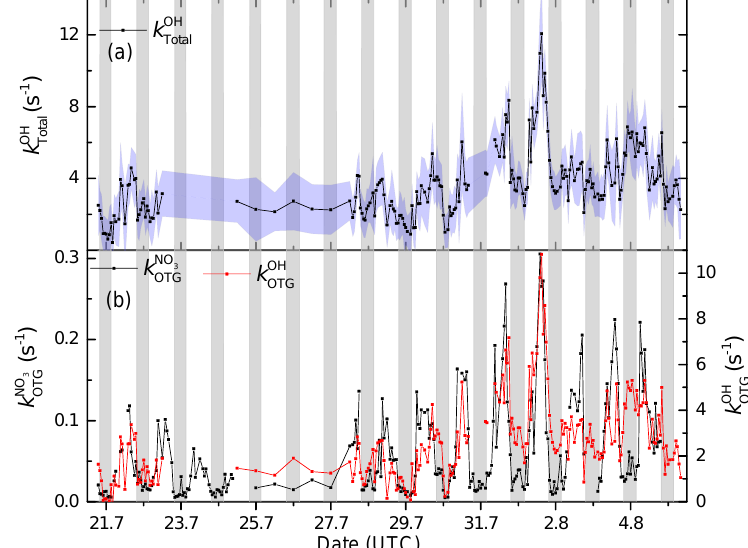
Figure 10. (a) Time series of k OH curves overlap at the peak reactivity (1 August).